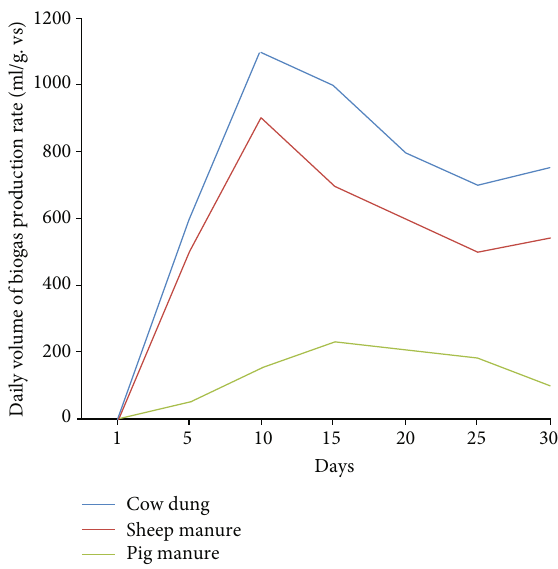
Figure 3: Daily biogas production in three samples.